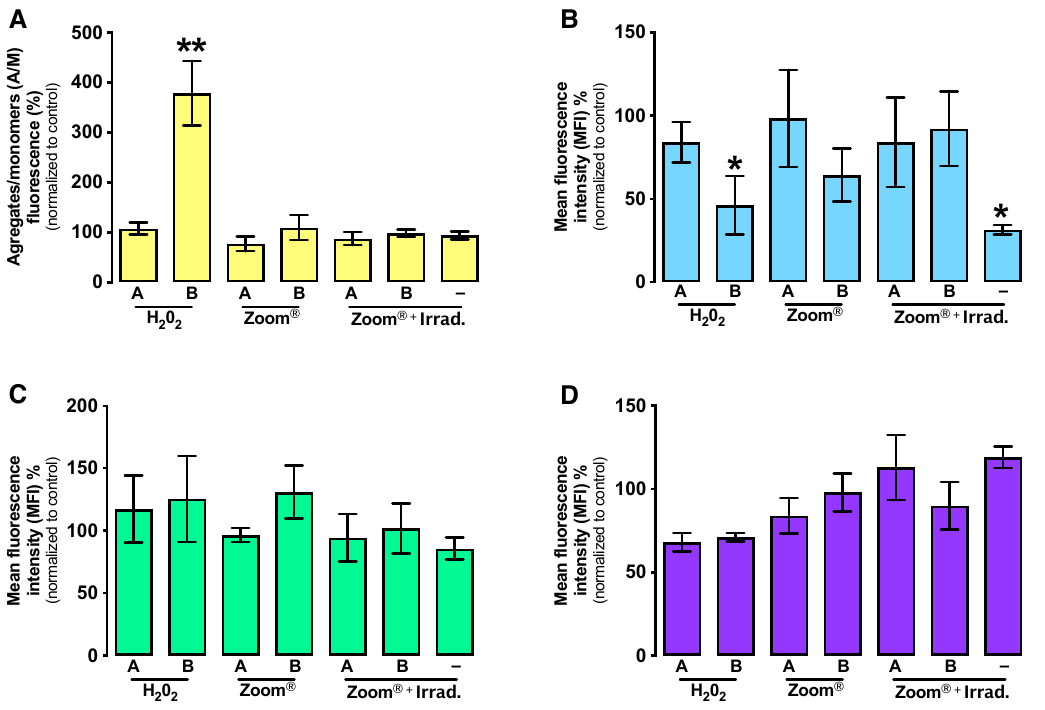
Figure 3. Oxidative stress analysis. ( A ) Mitochondrial membrane potential evaluation determined using the fluorescent probe JC-1. ( B ) Production of intracellular peroxides using DCFH2-DA. ( C ) Production of superoxide radical using DHE. ( D ) Expression of GSH using orange mercury. –: no compound administration. Statistical di ff erences from the respective control are indicated by *, where * represents p < 0.05 and ** p < 0.01. The results express the average of 5 independent experiments ± standard